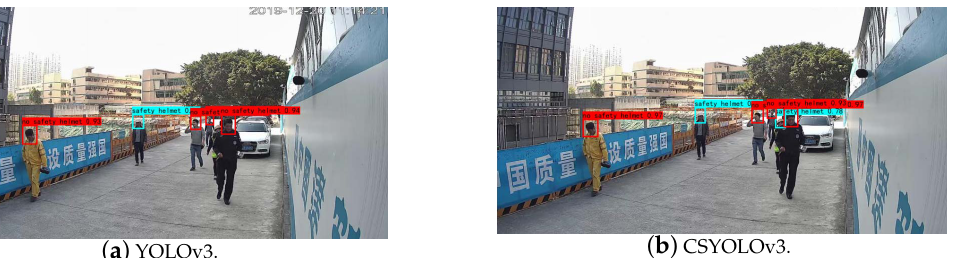
Figure 7. Results of normal safety helmet wearing (SHW) detection.